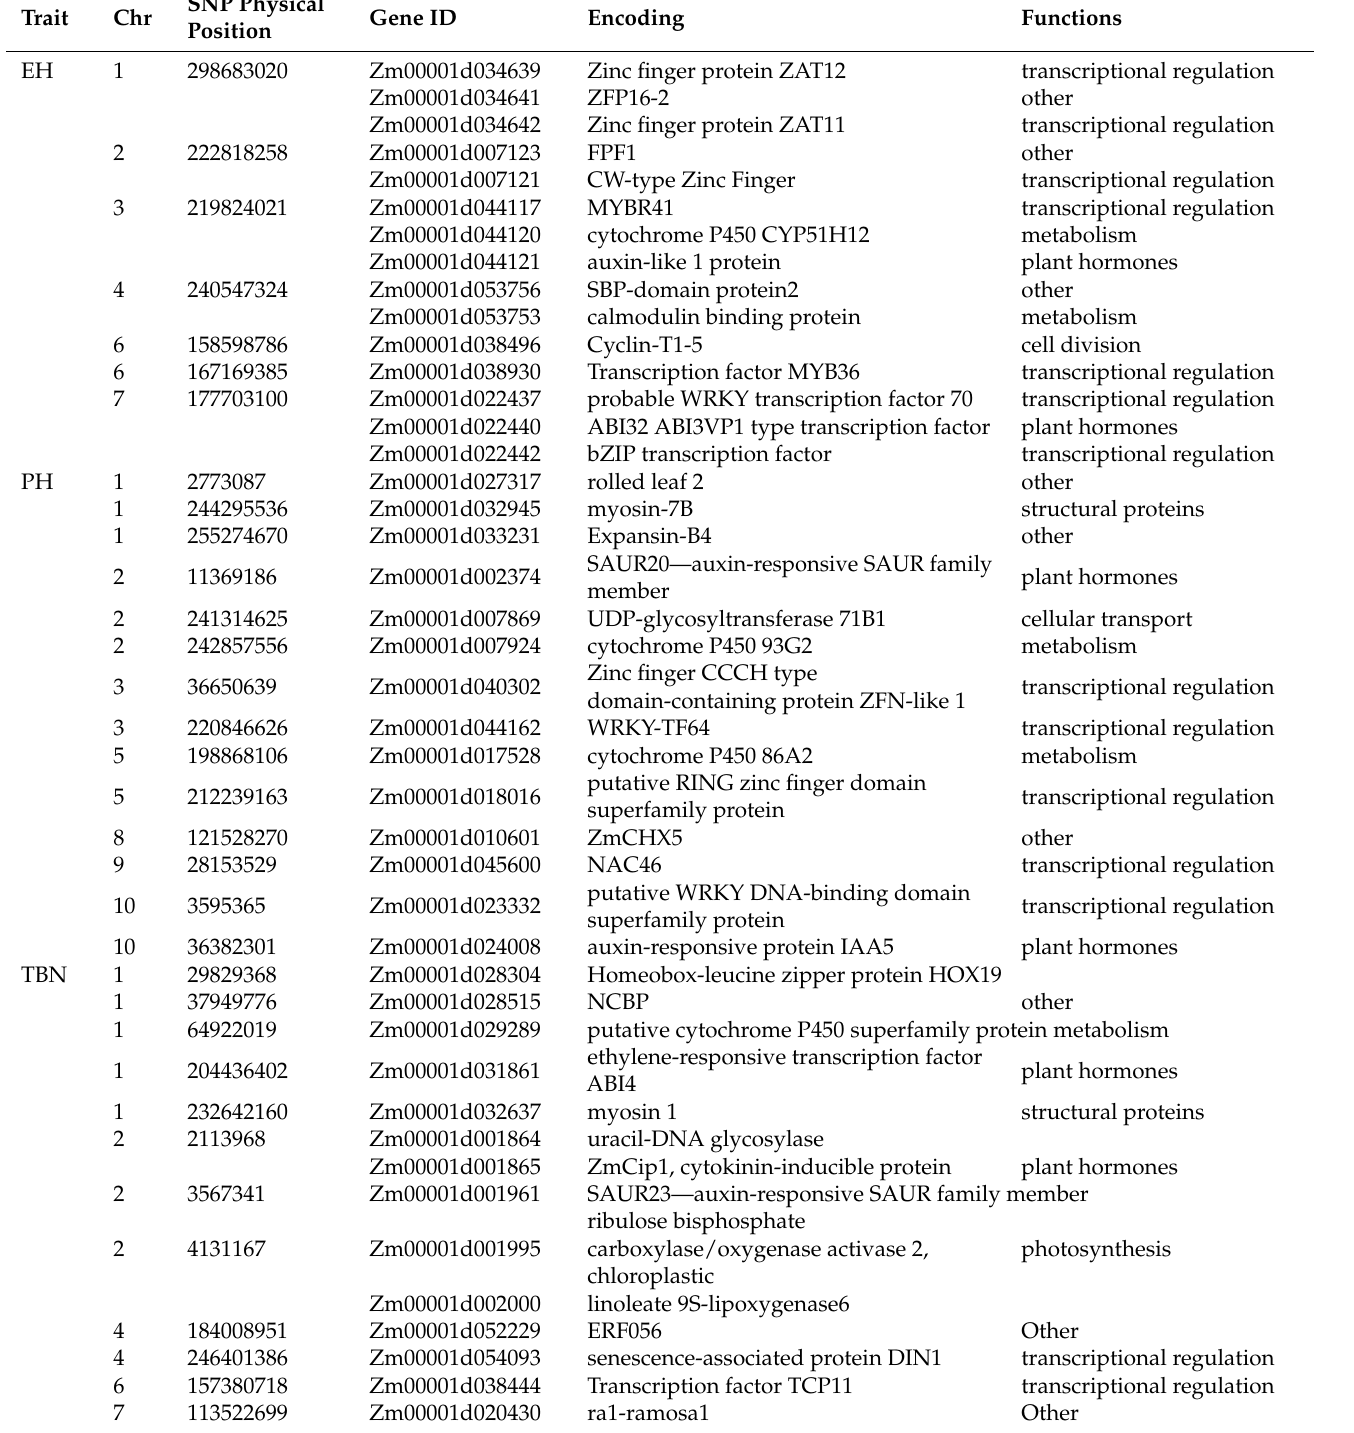
Table 2. Candidate genes for each significant SNP associated with traits and their encoding